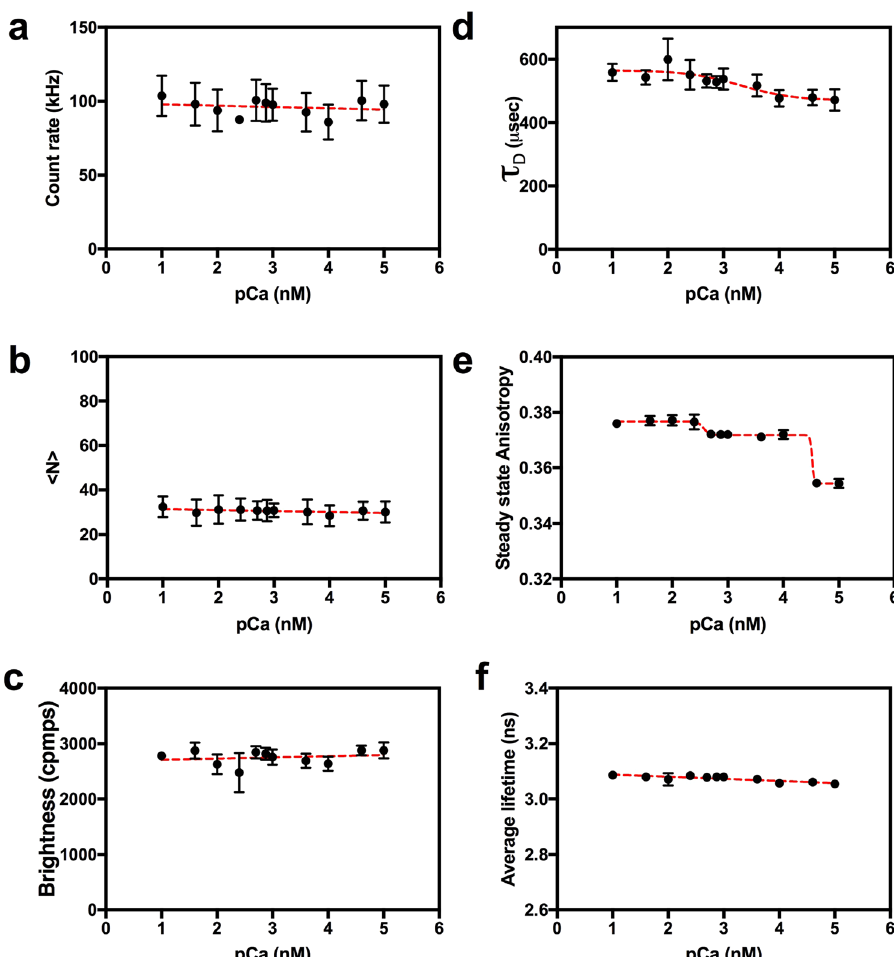
Figure 7. Auto-FPFA characterization of Venus-Twitch4-Venus, a homo-FRET based calcium biosensor. Auto-FPFA was used to measure count rate ( a ), < N > ( b ), brightness ( c ), diffusion time ( τ D , d ), steady state anisotropy ( e ), and average lifetime ( f ) of two different homogenates prepared from cells expressing Venus- Twitch4-Venus. Homogenates were diluted into buffers with defined calcium concentrations. Each point is the mean ± SD (N = 4, two from each homogenate preparations). Dashed lines are: a linear fit (panels a, b, c and f), a four parameter, variable slope dose-response fit (panel d) or a biphasic dose-response fit (panel